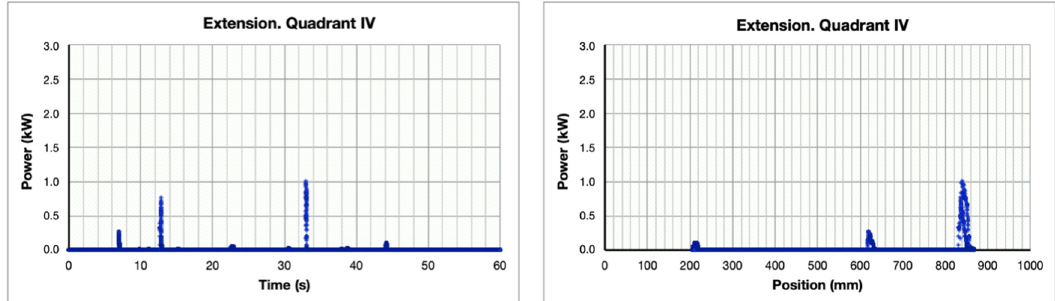
Figure 15. Recoverable power vs. time ( left ) and position ( right ) for the extension actuator in quadrant IV.